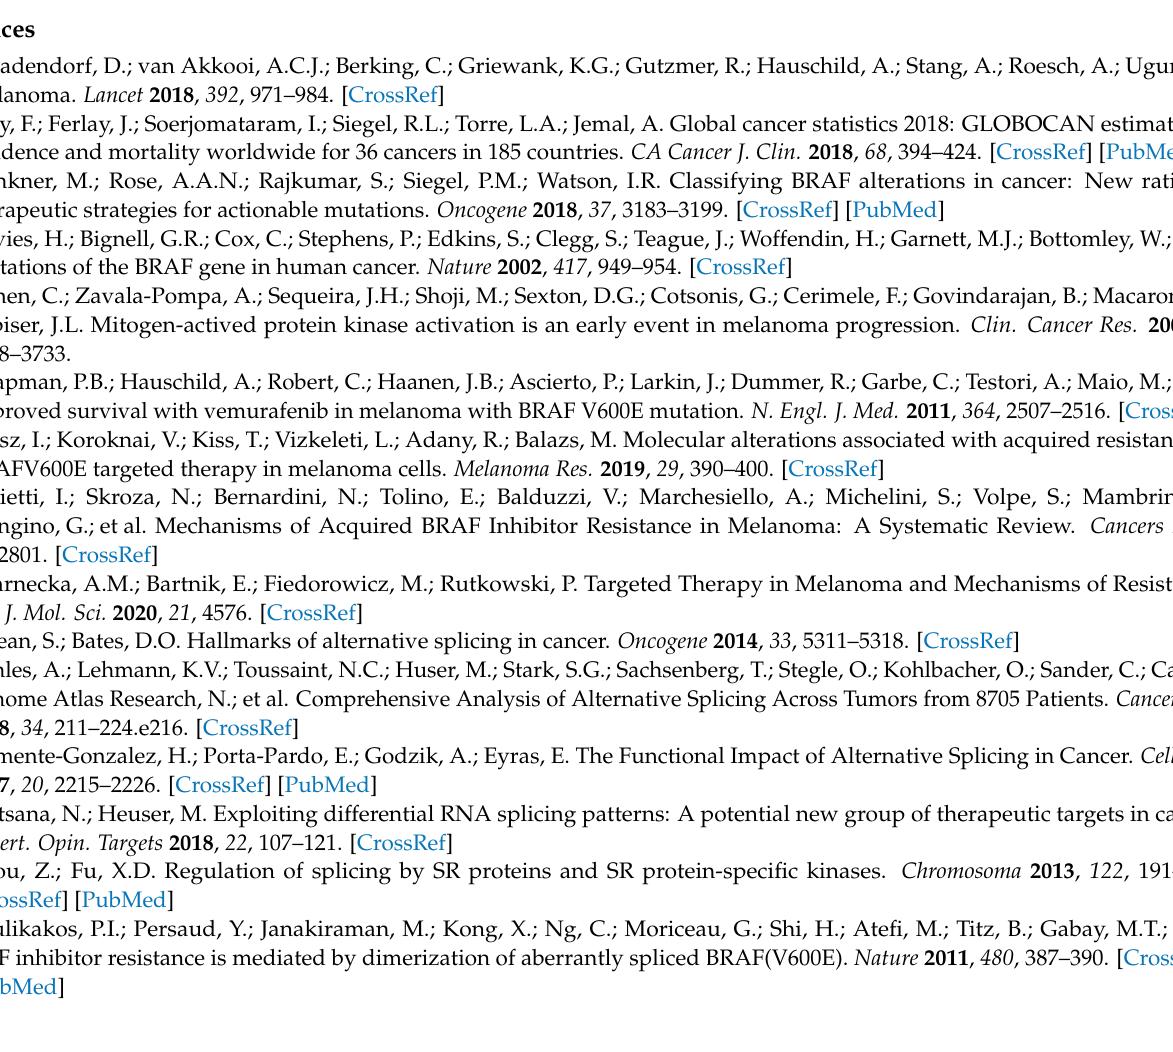
interactome MS data; Table S4:Splicing events; Table S5:RT-PCR primers sequences; Table S6: IPA comparison of canonical pathway enrichment for AS tools; Supplemental Materials and